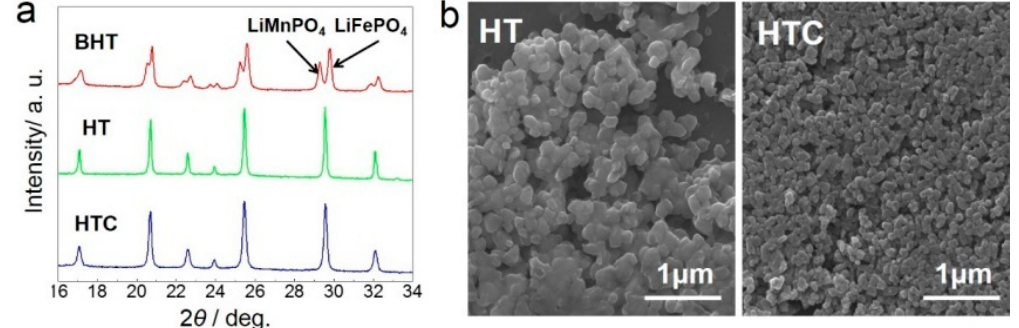
Table1. fwhm of HT and HTC at different peaks.